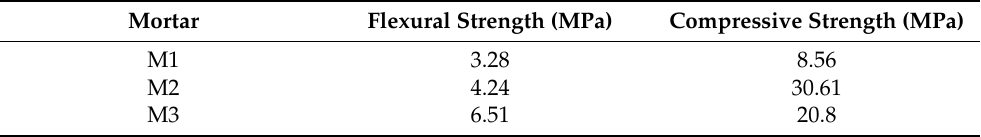
Table 4. Flexural and Compressive Strengths of Mortars.